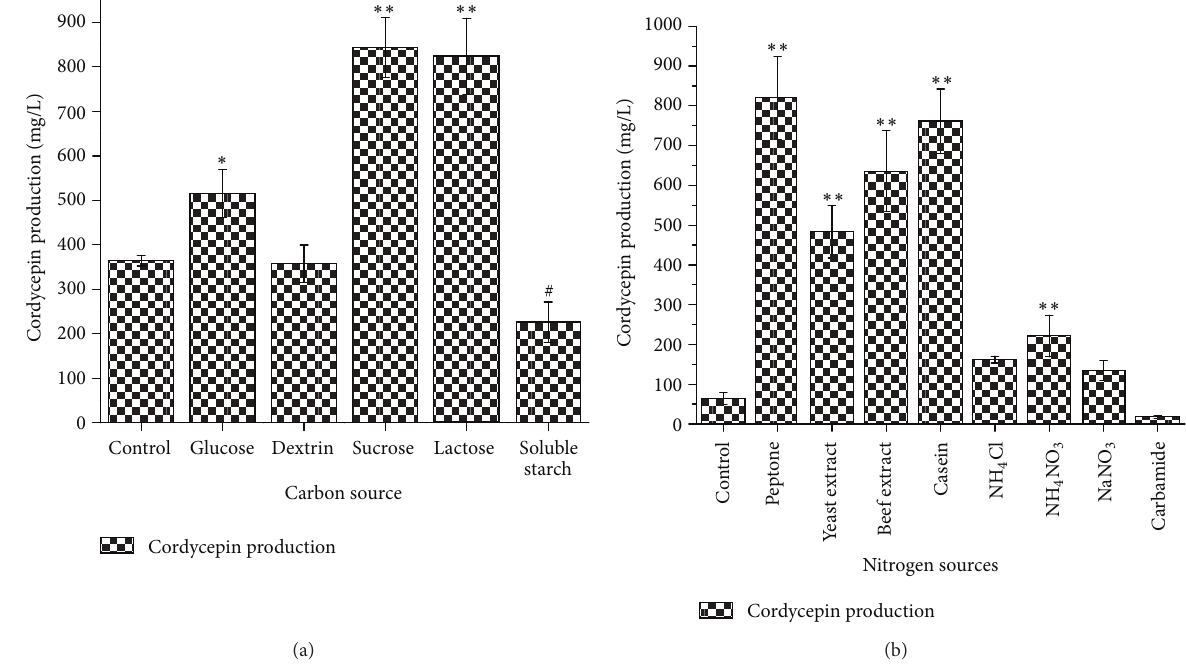
Figure 2: Effects of carbon sources and nitrogen sources on the production of cordycepin: carbon sources (a); nitrogen sources (b); ∗ 5 % significance level (test group versus control group); ∗∗ 1 % significance level (test group versus control group); # 5 % significance level (control group versus test group).